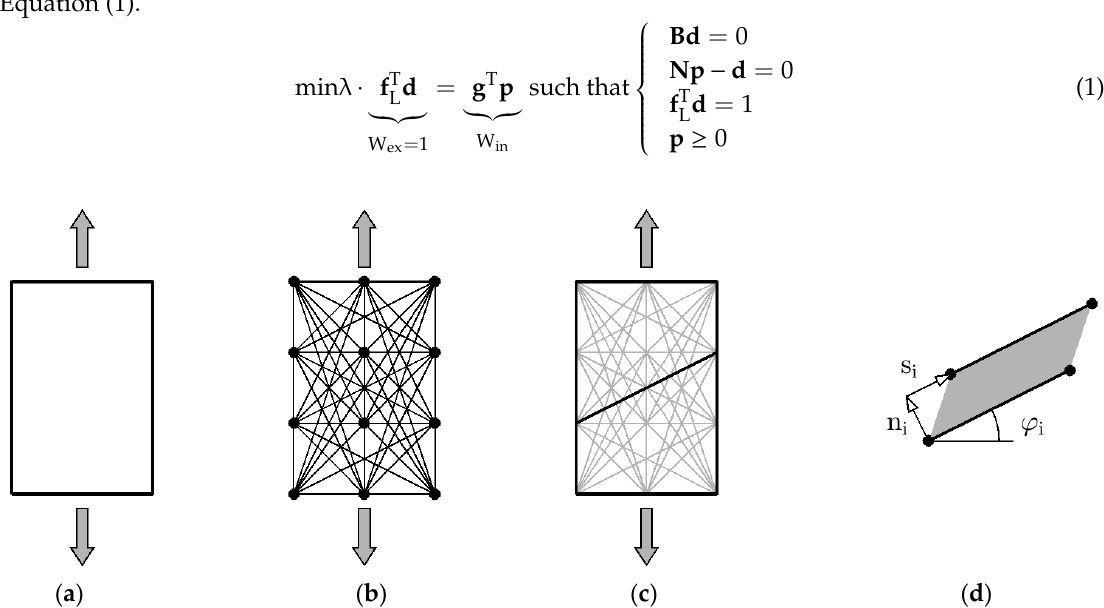
Figure 2. Discontinuity layout optimization (DLO) procedure: ( a ) Geometry, loading, and boundary conditions; ( b ) discretization with nodes and discontinuities; ( c ) obtained collapse mechanism; ( d ) definition of a single discontinuity i.